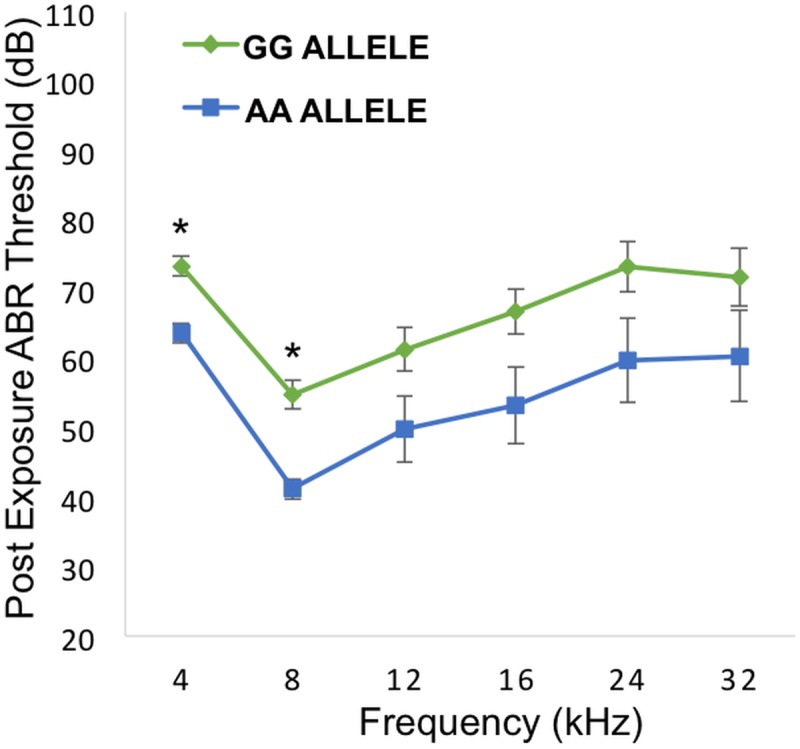
Genotypic effects of the peak SNP (rs33652818) at the Nox3 locus.Comparison between alleles GG and AA across the various frequencies. There is a statistically significant difference between the alleles at 4 and 8 kHz. * = p value < 0.001. Error bars +/- 1 SE.